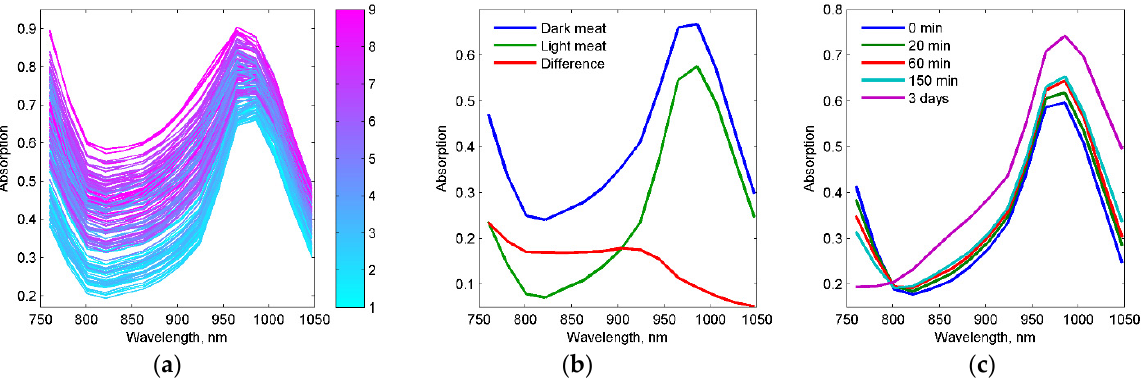
Figure 4. ( a ) NIR calibration spectra from loin slices. Colorbar indicates marbling scores for the slices. ( b ) NIR spectra from light and dark beef, including difference spectrum. ( c ) Spectral effects of blooming — oxygenation of myoglobin.